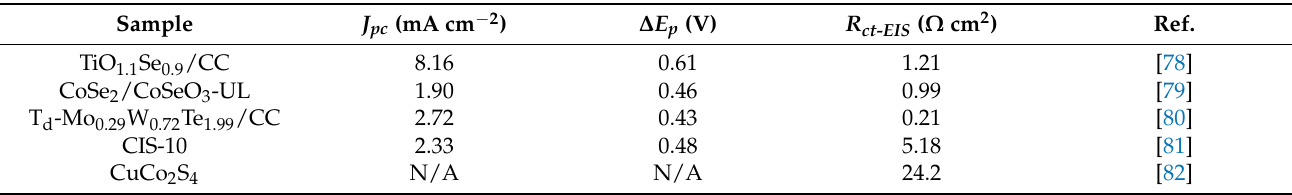
Table 6. The electrochemical parameters of various metal compound electrocatalysts measured in the I − /I 3 − -based